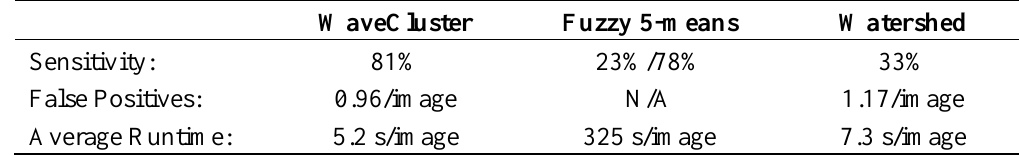
Table 1. Comparison of sensitivity, false positive rate, and runtime for the WaveCluster, fuzzy c-means (c = 5), and Watershed segmentation